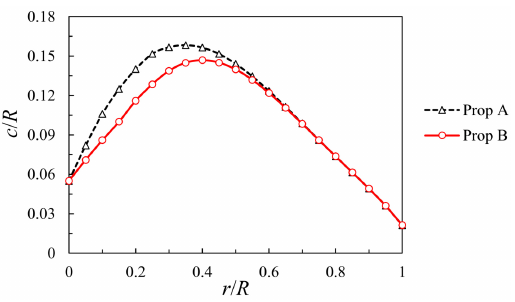
Figure 18. Blade chord distribution of the two optimized propellers.